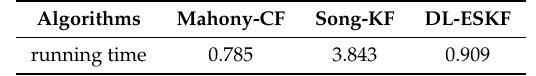
Table 8. Mahony-CF, Song-KF, and DL-ESKF running time(s) under static conditions.